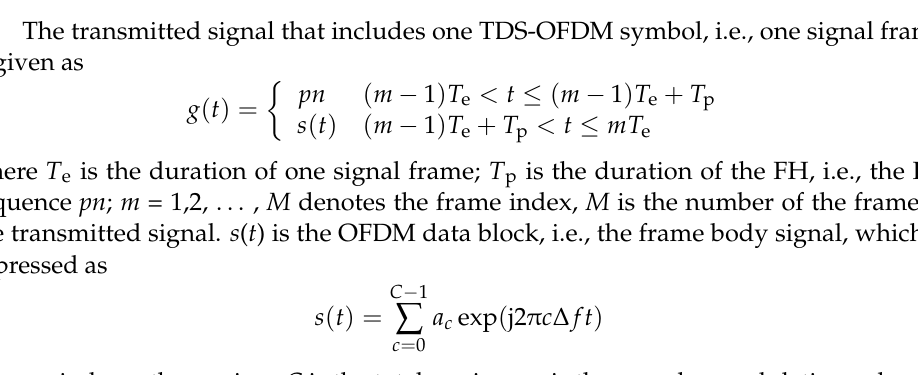
Figure 2. DTMB signal: ( a ) frame structure; ( b ) frame header structure of PN420 and PN945.